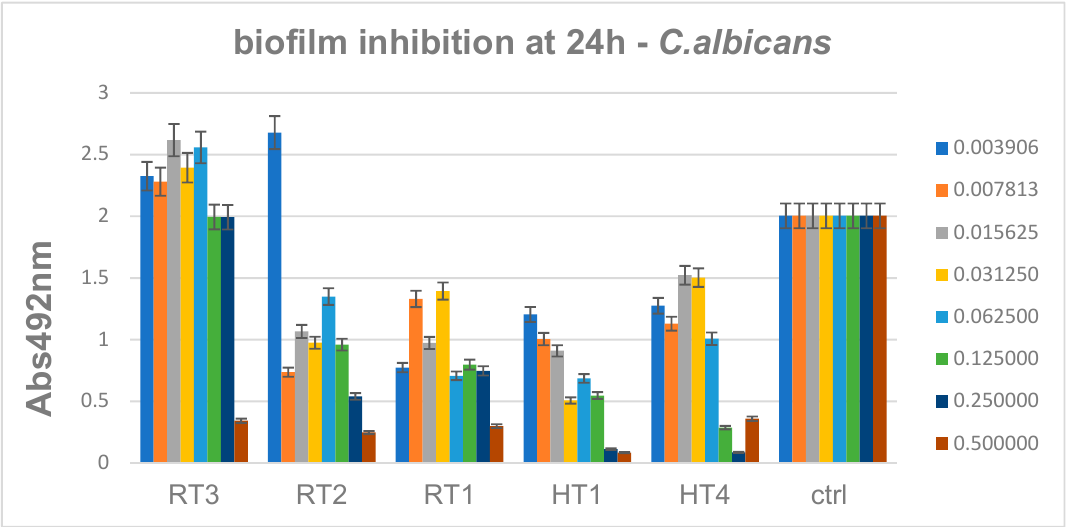
Figure 19. Inhibition of C. albicans biofilm development in the presence of the obtained AgNPs for 24 h.